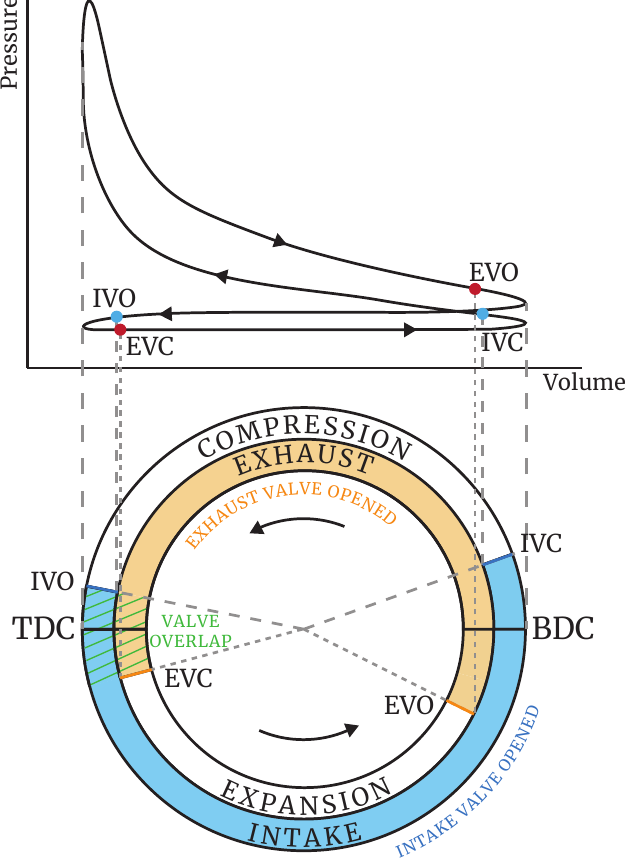
Figure 1. Four stroke diesel engine P-V diagram (top) and engine timing diagram